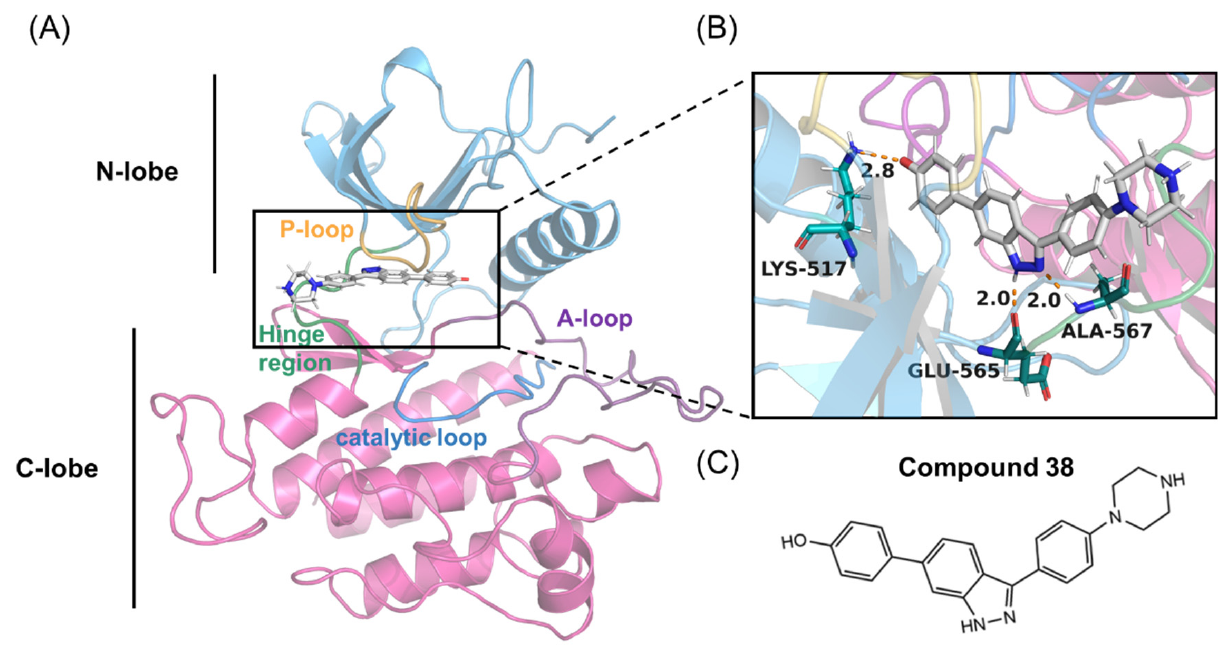
Figure 1. ( A , B ) Overall structure of the FGFR2 kinase domain in a complex with compound 38 (PDB code 7OZY). The N-lobe (blue) and C-lobe (pink), P-loop (orange), catalytic loop (marine), activation-loop (A-loop) (purple), hinge region (green), and compound 38 are highlighted. ( C ) Chemical structure of compound 38.